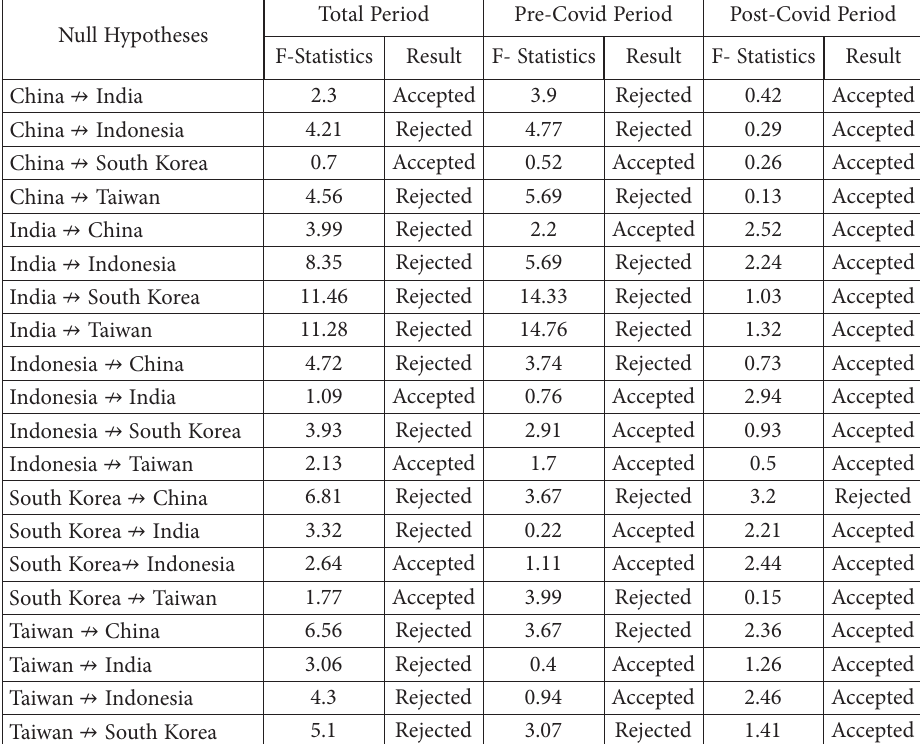
Table 5. Results of Granger causality tests (source: author’s calculations)